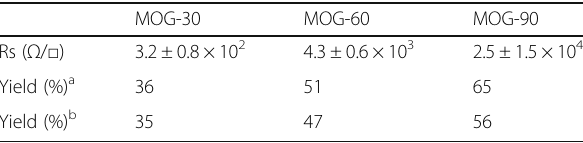
Table 1 Sheet resistance and yield of FLGO from MS exfoliation